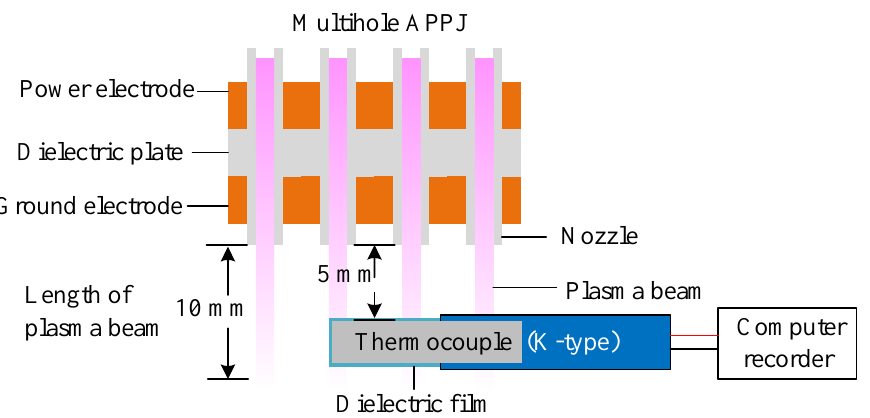
Figure 2. Schematic diagram of the multihole plasma jet with temperature measurement (not to scale).